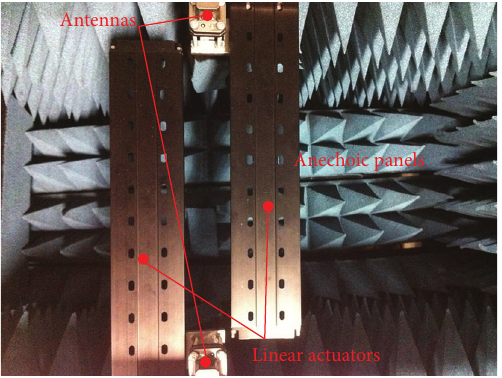
Figure 4: Top view of the